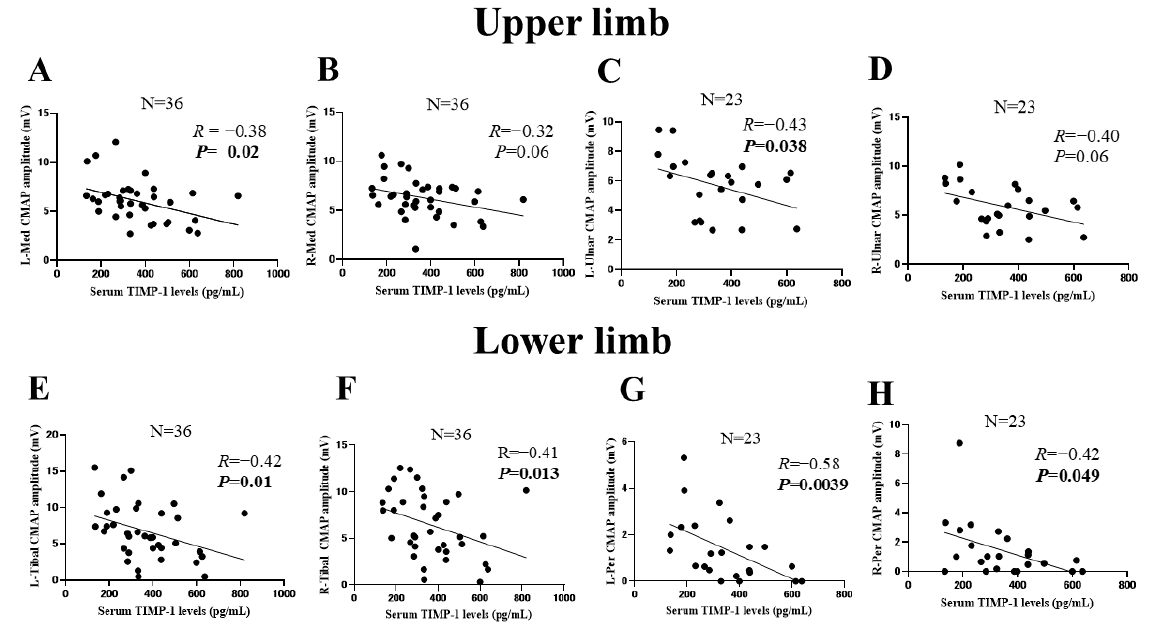
Figure 2. Correlations between serum tissue inhibitor of metalloproteinase-1 (TIMP-1) levels and compound muscle action potential (CMAP) amplitudes of the upper and lower limbs. ( A – D ) Correlations between serum TIMP-1 levels and CMAP amplitudes of the upper limbs: left median nerve ( n = 36, ( A )), right median nerve ( n = 36, ( B )), left ulnar nerve ( n = 23, ( C )), right ulnar nerve ( n = 23, ( D )). ( E – H ) Correlations between serum TIMP-1 levels and CMAP amplitudes of the lower limbs: left tibial nerve ( n = 36, ( E )), right tibial nerve ( n = 36, ( F )), left peroneal nerve ( n = 23, ( G )), right peroneal nerve ( n = 23, ( H )). Correlations were evaluated using Spearman’s correlation coefficients. A p -value of <0.05 was considered significant. L: left; R: Right; Med: median; Per: peroneal.